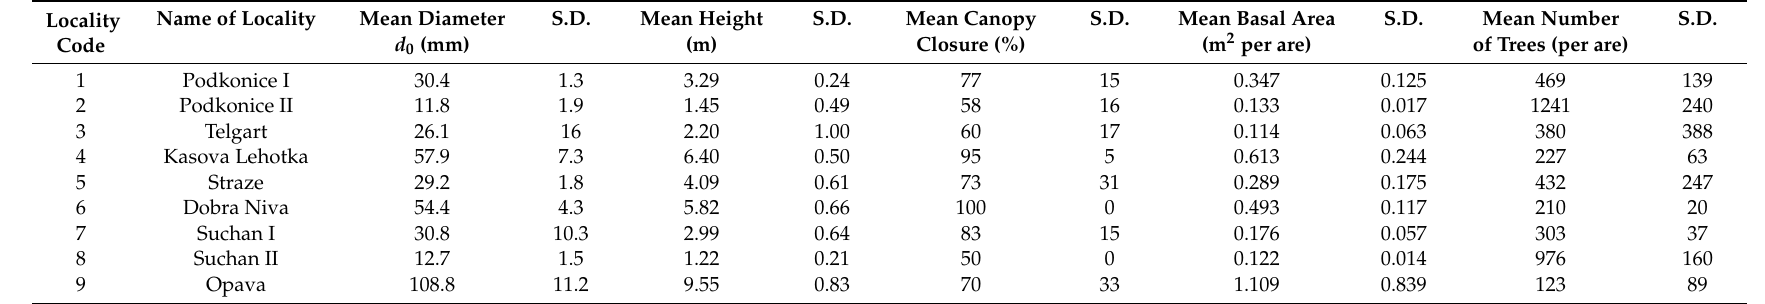
Table 2. Stand characteristics of common aspen (mean values and standard deviations were calculated from three circular plots). Locality